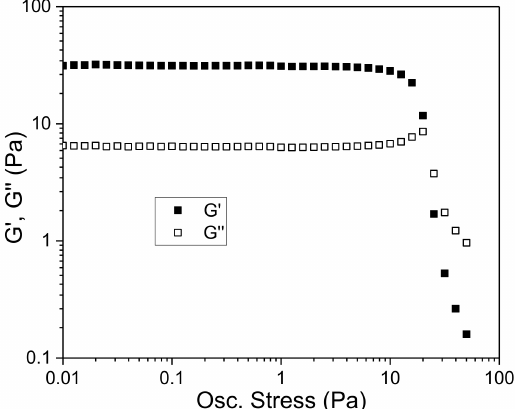
Figure 4. Storage (G’) and loss (G”) moduli at 1 Hz as a function of shear stress for the fennel oil nanoemulsion with 0.70 g/100 g of the AP xanthan gum. Standard deviation of the mean (three replicates) for all the data are below 5%. (T = 20 ◦